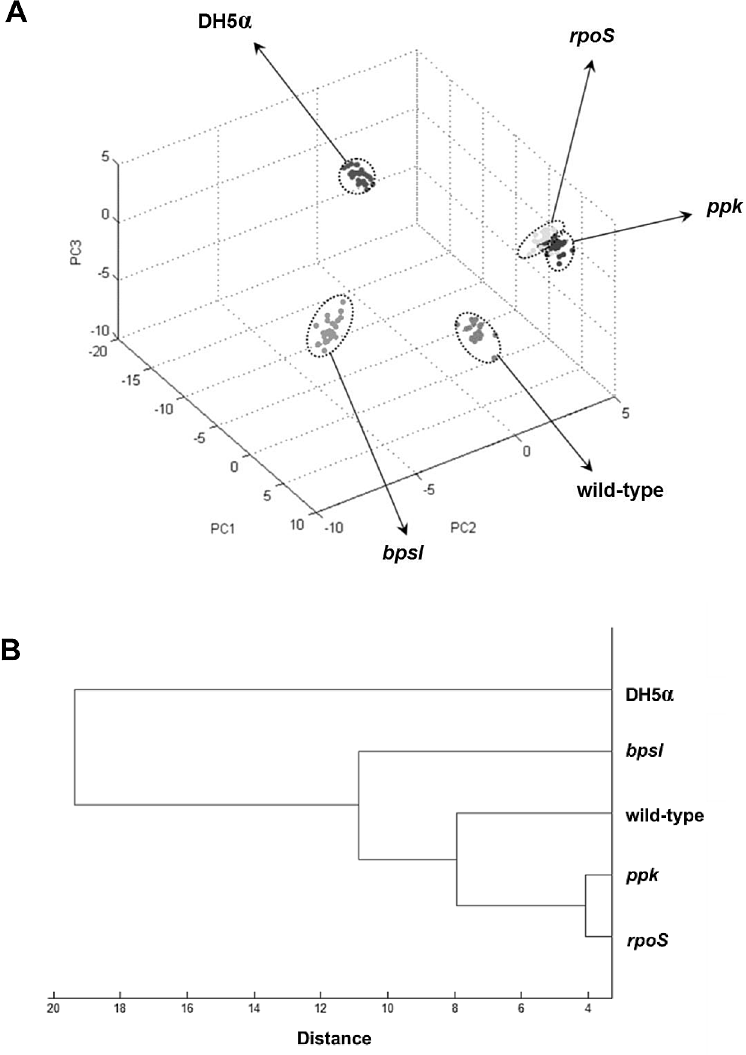
Fig 4. Cluster analysis of B . pseudomallei wild-type and mutants. (A) PCA score plot representing clusters of each isolate (dashed circles) illustrated separately distribution with the rpoS and ppk isolates producing a much closer cluster. (B) Dendrogram derived from PCA scores demonstrates that B . pseudomallei PP844, rpoS , and ppk clustered on the same clade, while a clade of bpsI showed a greater distance than